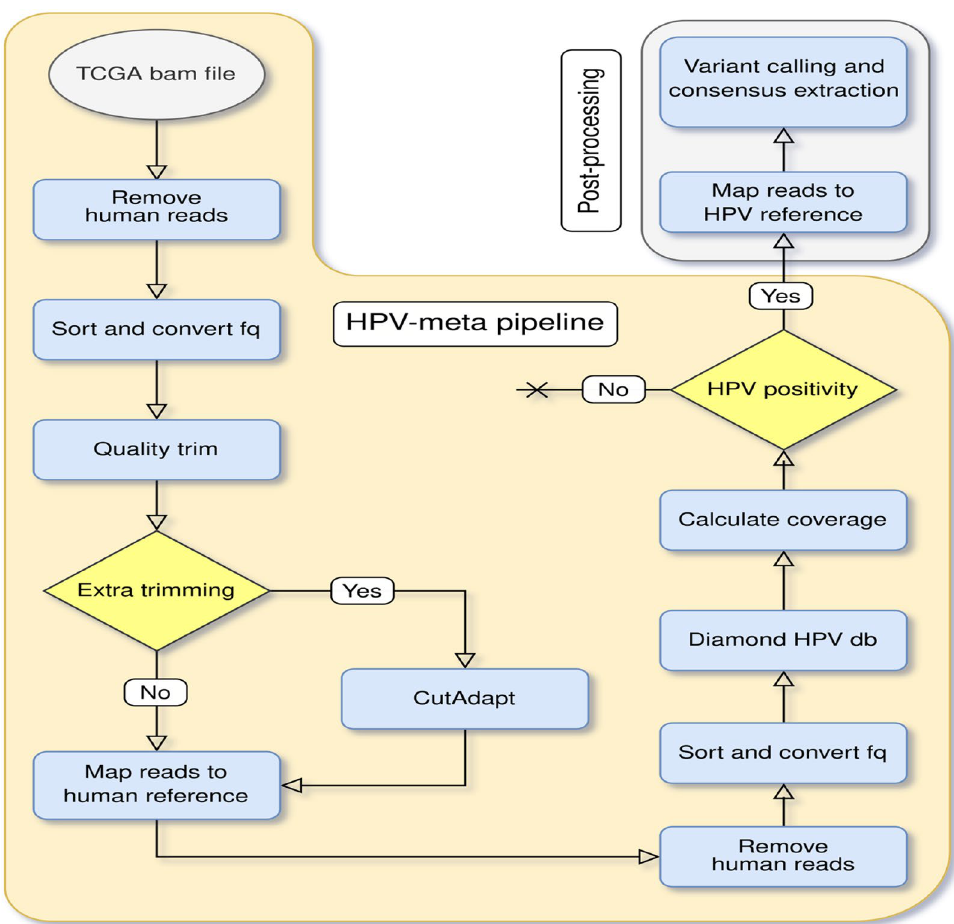
Figure 1. “HPV-meta” pipeline for detecting HPV transcripts in RNA sequencing data. Flowchart describing the pipeline steps included in “HPV-meta”. The pipeline includes removal of human reads, sort and